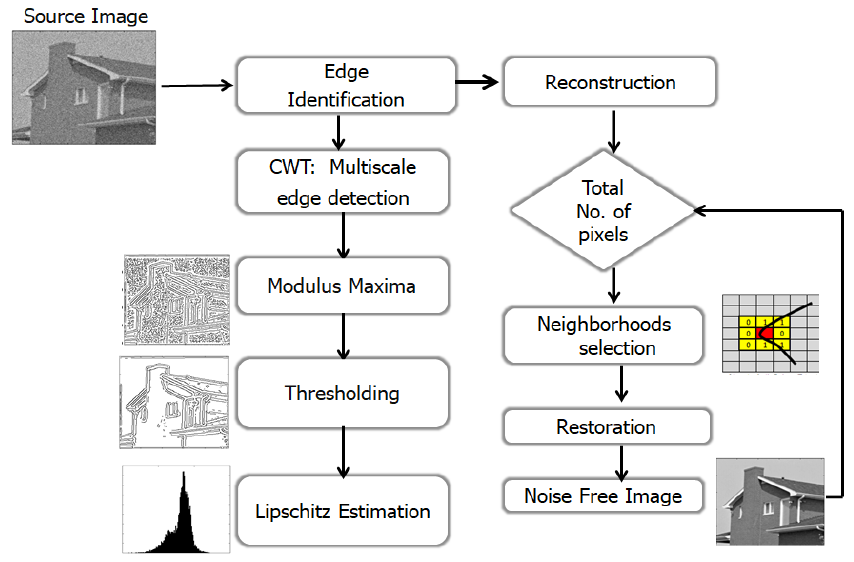
Figure 2. Block diagram of the